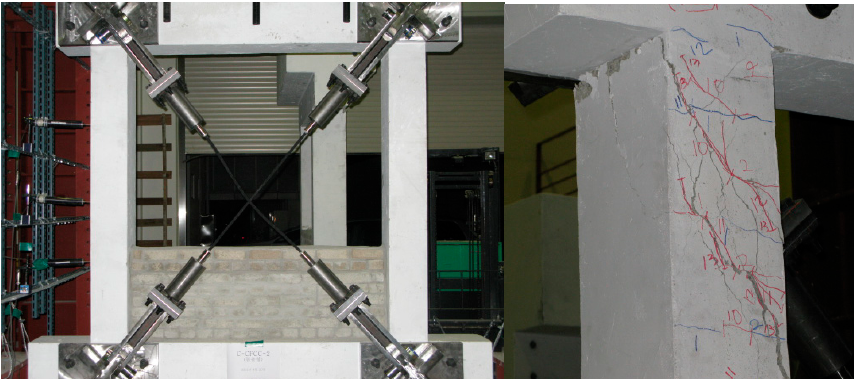
Figure 10. The CFCC-2 specimen following the cyclic load tests.